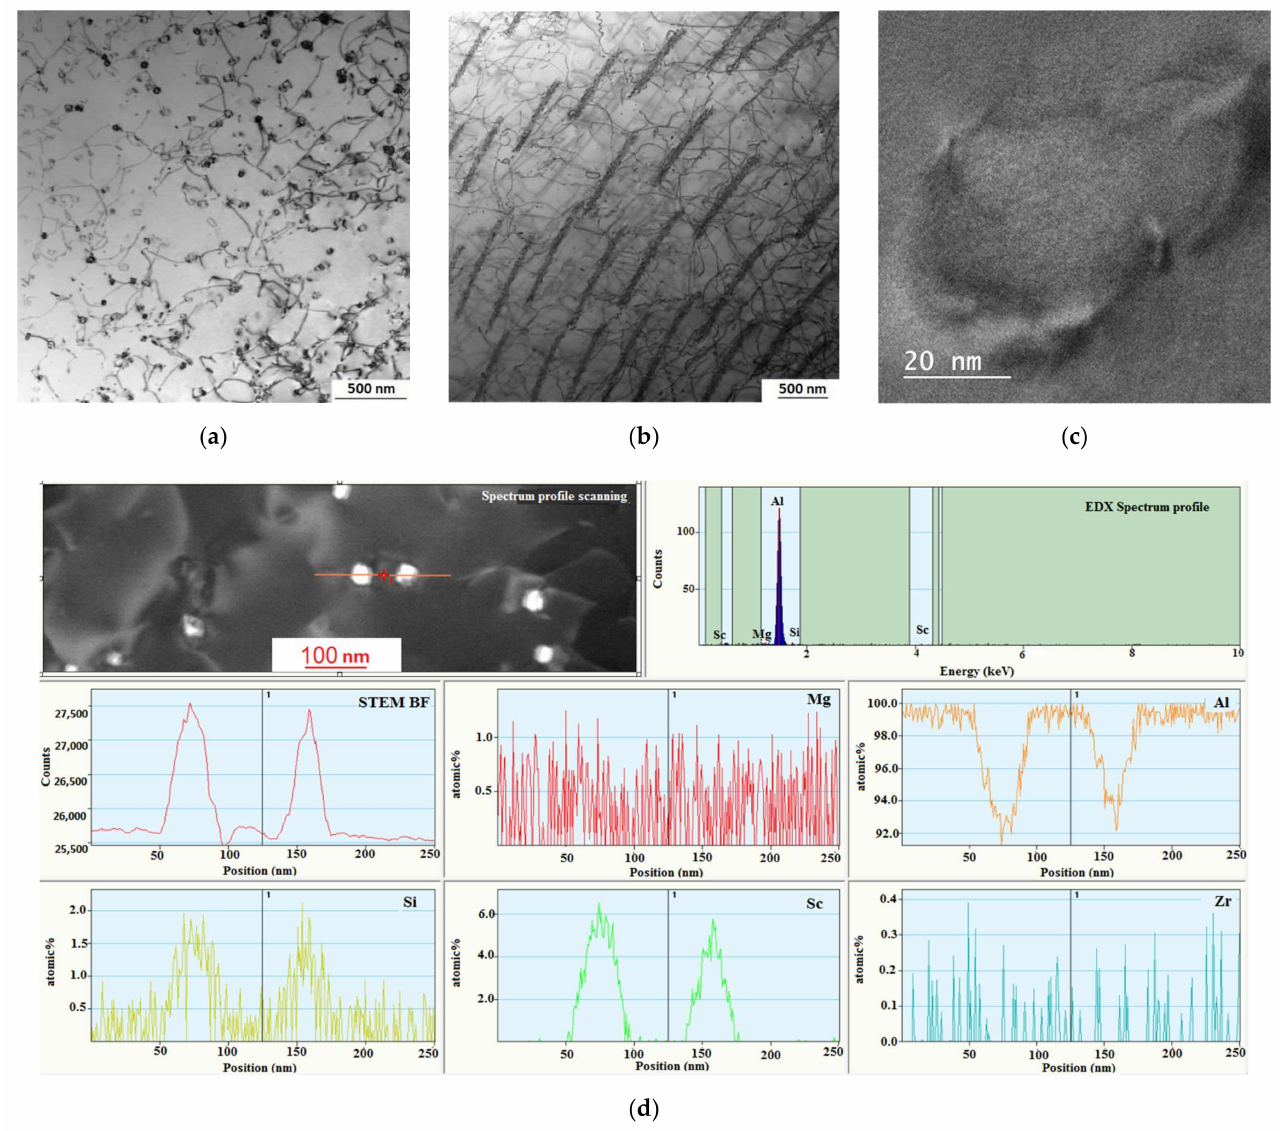
Figure 11. Al 0.3 Mg 1 Si 0.15 Zr 0.3 S copper cone ( a ) Al 3 Sc particles, bright field; ( b ) Al 3 Sc particles, dark field in the superstruc- tural reflection; ( c ) Al 3 Sc particles with zirconium, bright field; ( d ) EDS profile line